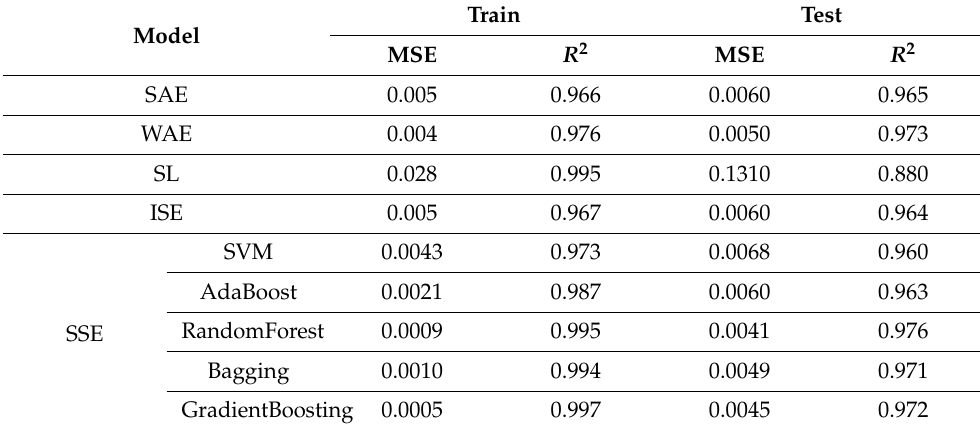
Table 5. Performance evaluation of the models.